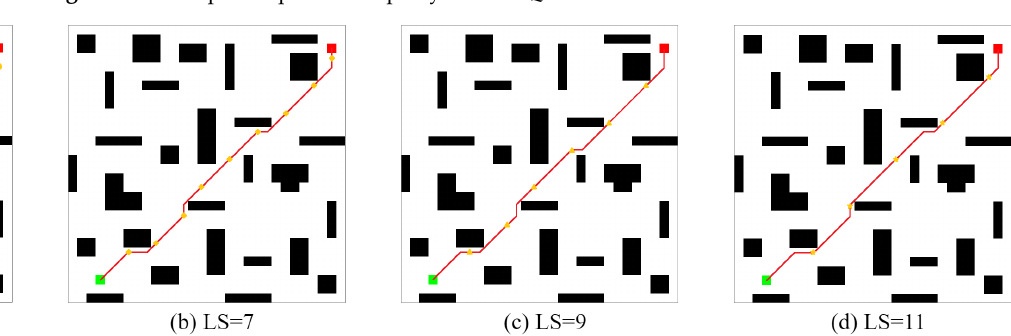
Figure 16. The optimal path of Map1 by the CLSQL.